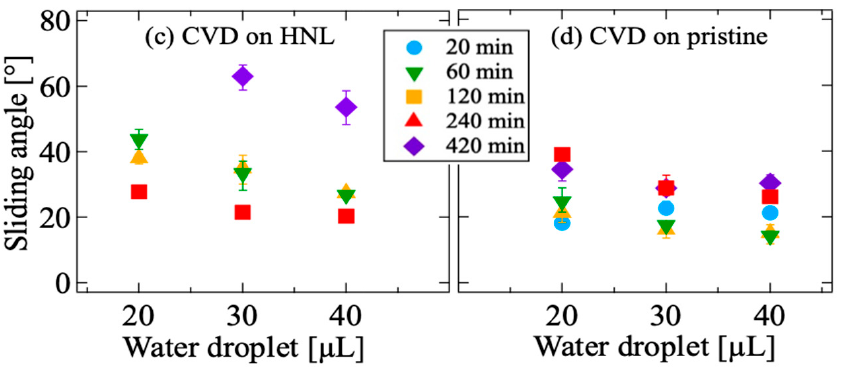
Figure 2. Sliding angles of water droplets on the PDMS-coated glass prepared ( a , b ) by baking and ( c , d ) by thermal CVD. CVD took more time to make HNL hydrophobic than baking, though the methods worked similarly on pristine glass.